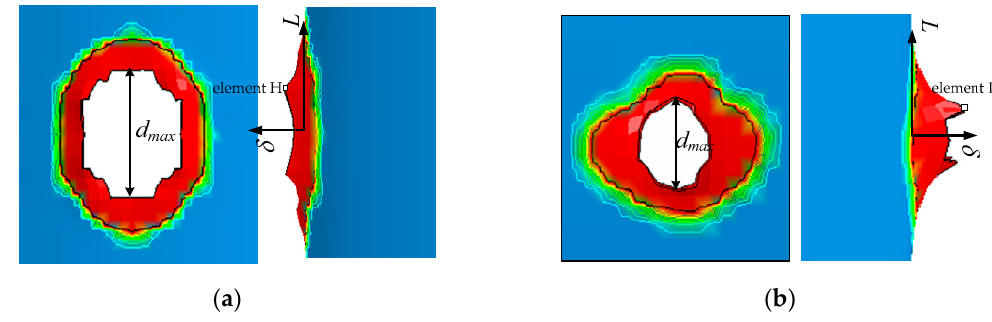
Figure 8. ( a ) Perforation and bulge on the front wall. ( b ) Perforation and bulge on the back wall.